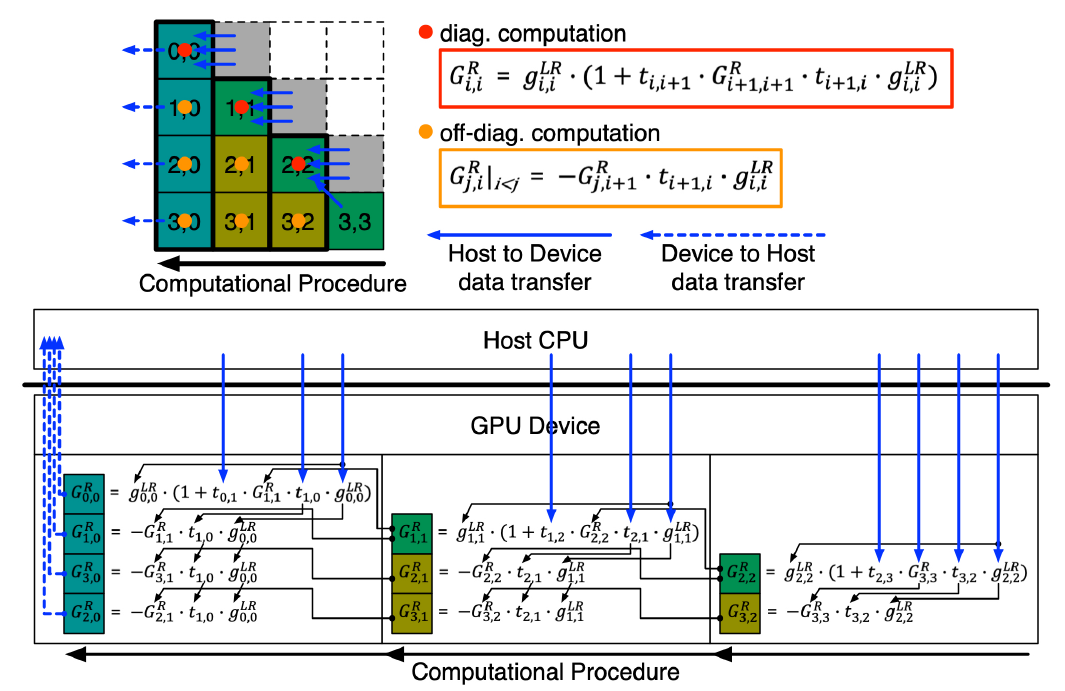
Figure 6. The scheme of offload computing for RGF step 3 is described by the case when the nanostructure has a single unitcell along the X-direction (X-UC = 1). Half of the off-diagonal sub-matrices of the inverse matrix are evaluated with the consecutive multiplication of sub-matrices, whose computational flow is shown with large black arrows. Sub-matrices needed for computation at each column are either transferred from the host or derived from the calculation at the previous column. The performance gain derived with offload computing becomes larger as the nanostructure has more X-UCs, since the increase in the number of matrix multiplications is much bigger than the increase in the number of sub-matrices that must be transferred from the